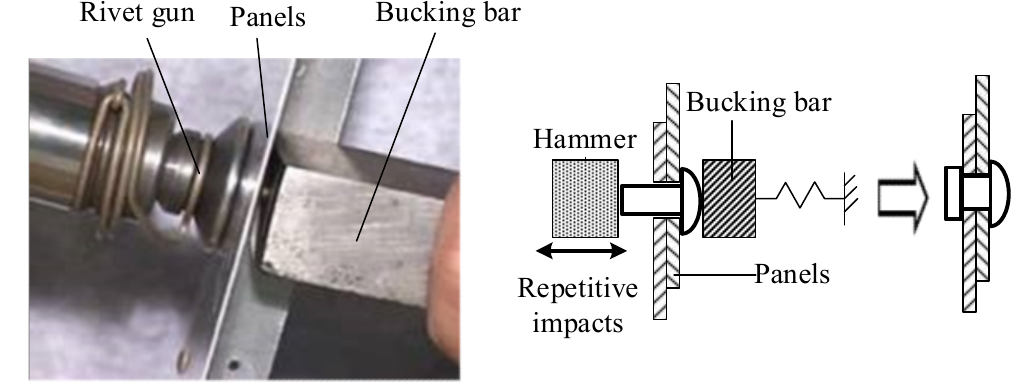
Figure 8. Principle of percussive riveting.